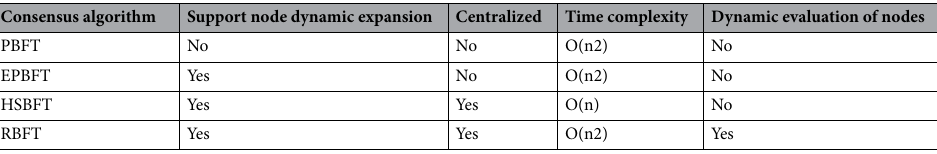
Table 1. Comparison of PBFT, EPBFT, HSBFT, RBFT